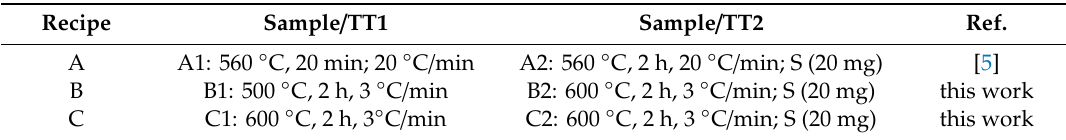
Table 1. Annealing conditions for TT1 and